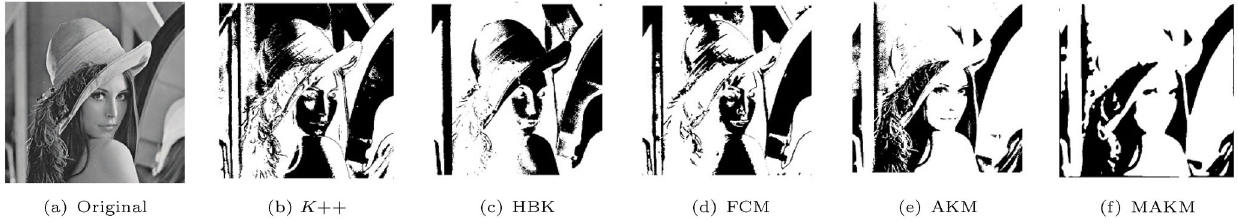
Fig. 7 Lena-labeled image segmented using various